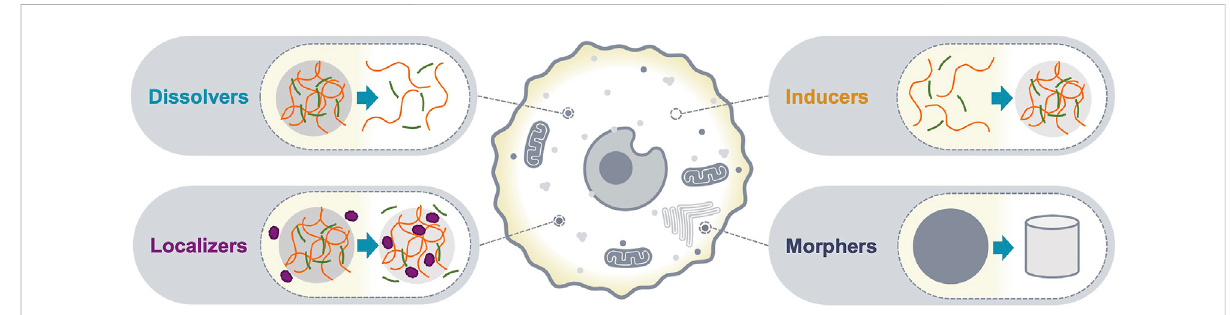
FIGURE 1 c-mod classes. A schematic representation of the optical phenotypes of condensate modi fi cation used to classify c-mods. Dissolvers drive dissolution of an existing condensate. Inducers cause assembly of a new condensate. Localizers alter the localization of speci fi c condensate community members. Morphers alter the physiochemical properties of an existing